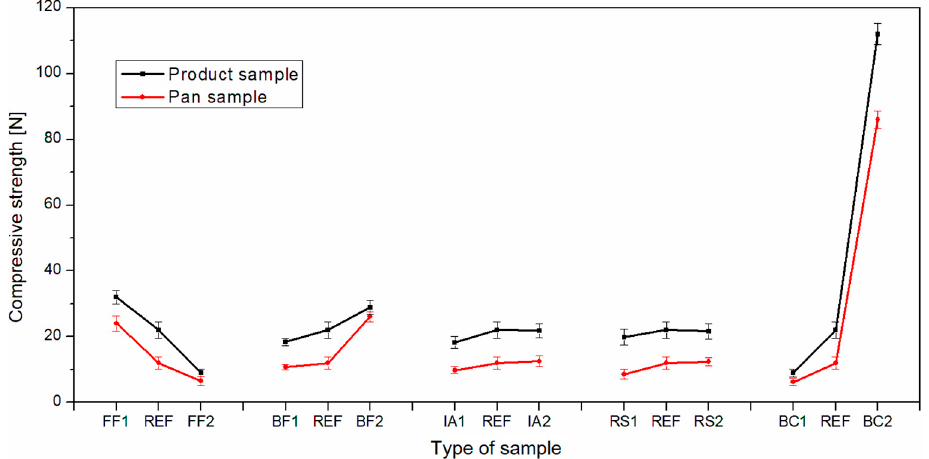
Figure 15. Influence of the operating parameters on compressive strength. For particle humidity (Figure 16), binder feed, rotational speed, and binder content levels do not significantly affect the trajectory separation. In contrast, different feed flow rates and angles of inclination had mild effects on the trajectory separation.